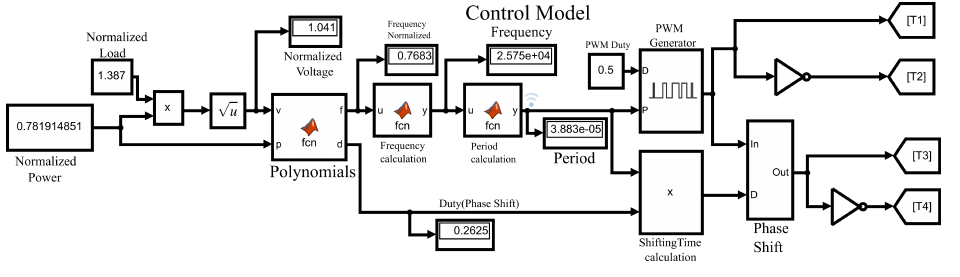
Figure 11. One-input Simulink control model.